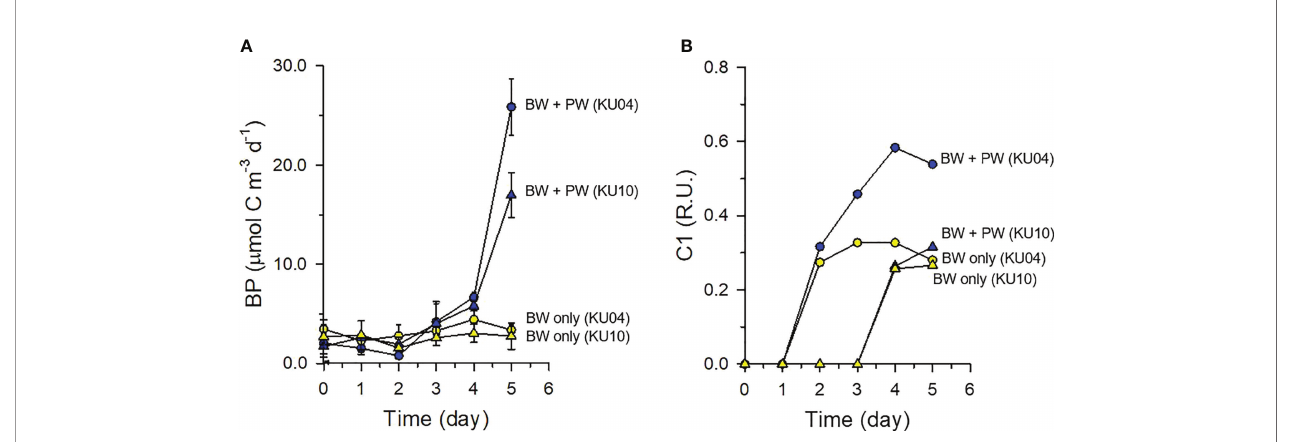
FIGURE 6 | Heterotrophic bacterial production (BP) (A) , and normalized fl uorescence intensity of component 1 (C1) of humic-like FDOM during the incubation experiment conducted at the slope site (KU4) and basin site (KU10) (B) . Normalized fl uorescence intensity was calculated by subtracting the fl uorescence intensity at each time point from that of time